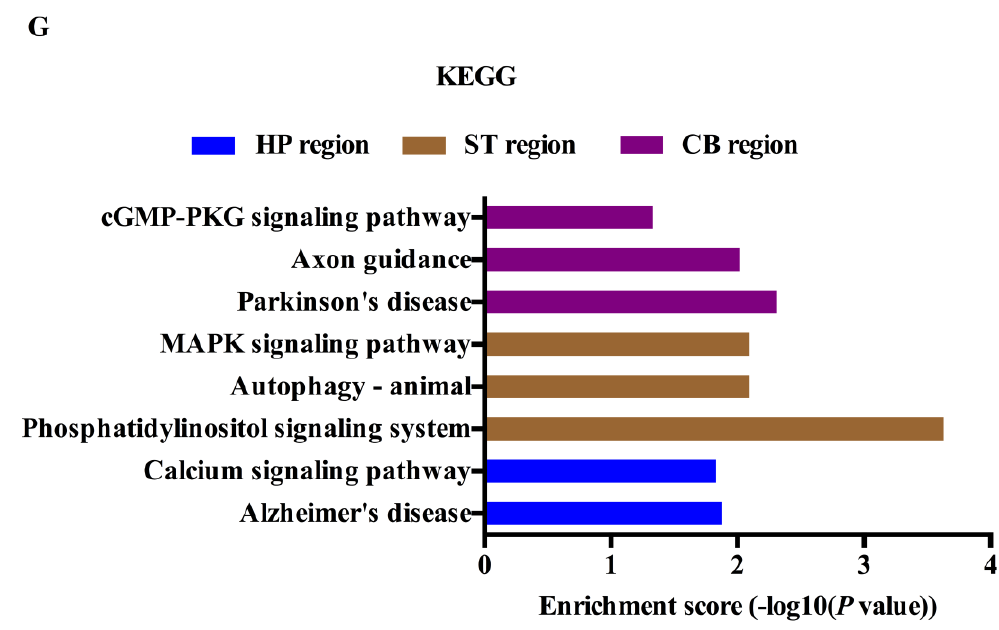
Figure 4. Gene ontology (GO) analyses of the DE-circRNAs parental genes in the ST and CB regions. ( A ) GO function classification of all DE-circRNAs in the ST region. ( B ) Bar chart of all DE-circRNAs clusters in the ST region. ( C ) GO function classification of all DE-circRNAs in the CB region. ( D ) Bar chart of the top 20 DE-circRNAs clusters in the CB region. ( E ) GO function classification of all DE-circRNAs in the HP region. ( F ) Bar chart of the all DE-circRNAs clusters in HP region. ( G ) The enriched KEGG pathways of the DE-circRNAs parental genes in different brain regions.